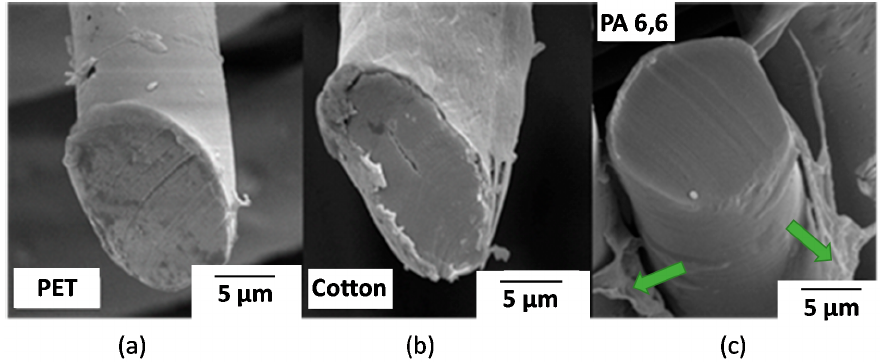
Figure 1. Scanning electron microscopy (SEM) images of ( a ) poly(ethylene terephthalate) (PET), ( b ) cotton, and ( c ) nylon 6,6 (PA 6,6) single fibers coated with nanofibrillated cellulose (NFC). Arrows point to the peeled fraction of the NFC coating.